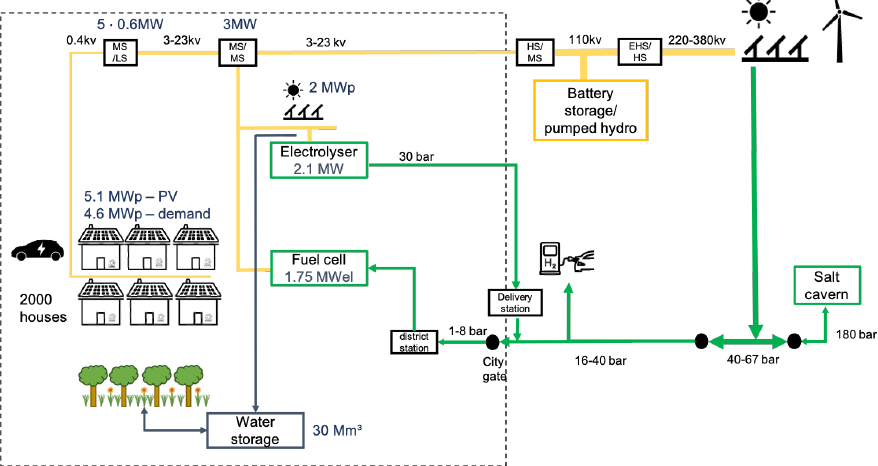
Figure 4. Schematic overview of the all-electric H 2 scenario that includes both an electrolyzer and fuel cell for local hydro- gen production and uses while preventing grid reinforcement. The electricity supply by PV and electricity demand is the same as in the all-electric scenario (Figure 3), but instead of grid reinforcement, an electrolyzer (2.1 MW el ) shaves peaks in electricity export. On the other hand, the fuel cell has a sufficient capacity (1.75 MW el ) to shave demand peaks, thereby avoiding grid reinforcement. The fuel cell is utilized as a baseload installation in the system. The fuel cell would have a very low usage otherwise (0.3% of the year). This scenario will import more hydrogen than electricity, so the effect of large amounts of hydrogen import can be assessed.